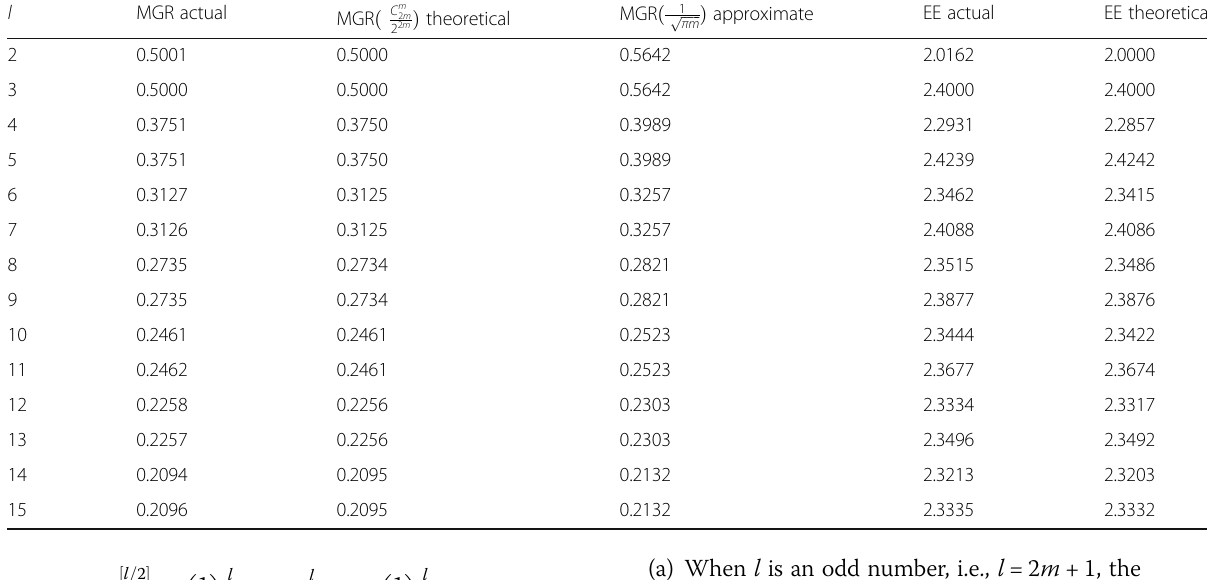
Table 2 Comparison of experimental and theoretical value of MGR and EE